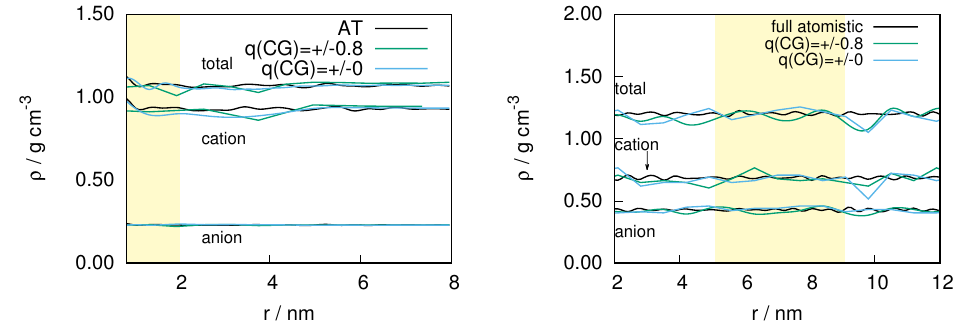
Figure 1. The density of ion pairs as a function of the distance from the center of the atomistic region for [ BMIM ][ Cl ] ( left ) and [ BMIM ][ BF 4 ] ( right ). For the [ BMIM ][ BF 4 ] , the simulation box was split in x-direction, so the weight is a function of the x -coordinate and all distances are measured using the x -coordinate. In the case of [ BMIM ][ Cl ] , the AdResS simulation was performed with spherical explicit zone. The radius of the atomistic (shown in yellow) is 2 nm. The width of the hybrid region that borders the atomistic region is set to 2 nm. The remaining region corresponds to the coarse-grained region in the AdResS